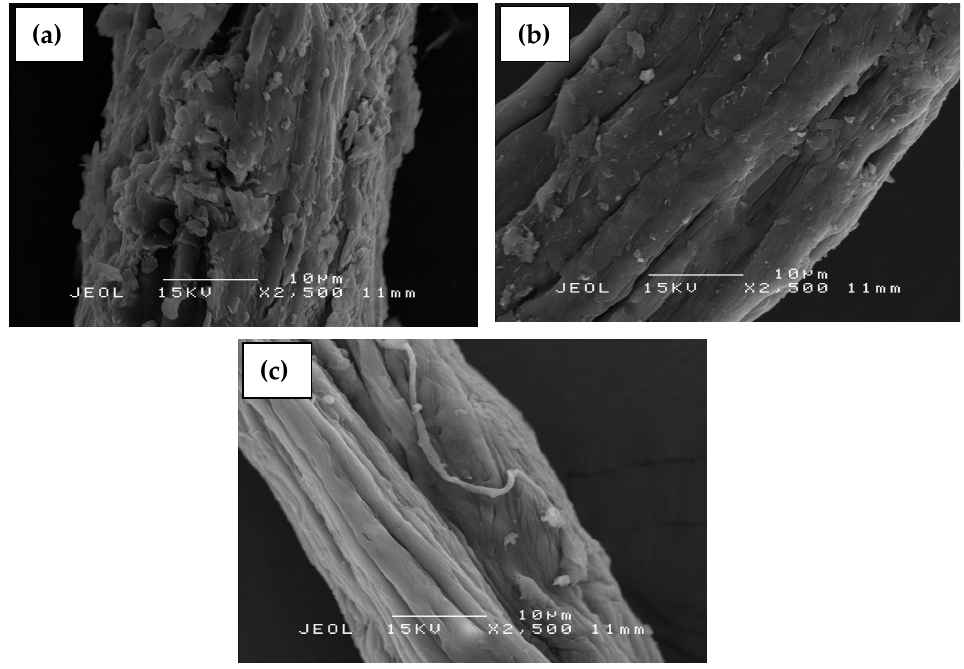
Figure 6. SEM micrographs of ( a ) OPMF, ( b ) alkaline treated OPMF and ( c ) bleached OPMF.